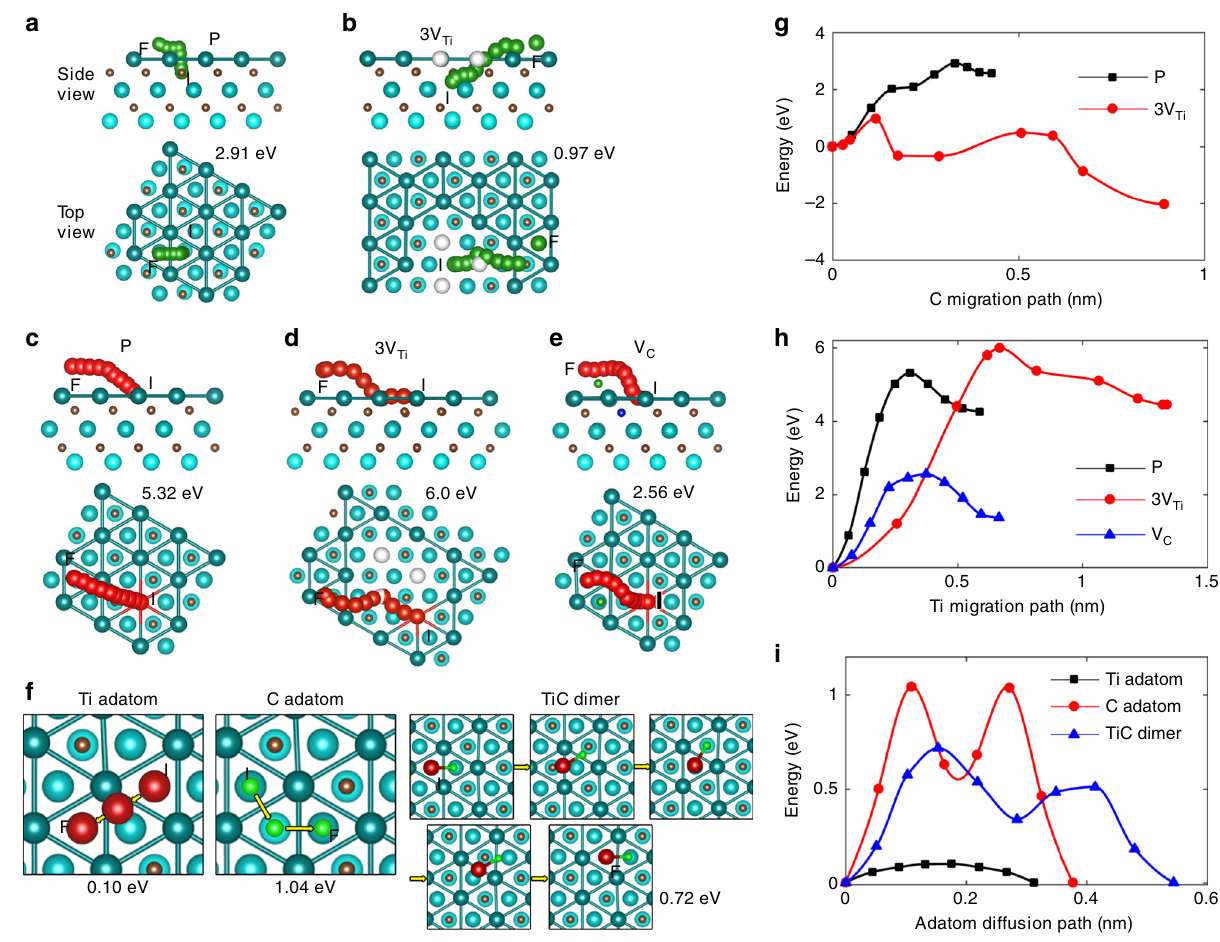
Fig. 3 Migration and diffusion barriers for Ti and C atoms. a – e Carbon atom migration pathways for a perfect crystal ( “ P ” , a ), and with help of 3-V Ti cluster ( “ 3V Ti ” , b ); and titanium atom migration pathways for a perfect crystal ( “ P ” , c ), with help of 3-V Ti cluster ( “ 3V Ti ” , d ), and with help of a single C vacancy ( “ V C ” , e ). “ I ” and “ F ” denote the initial and fi nal positions of the migration paths. Cyan, Ti; gold, C; red, diffusing Ti atom; green, diffusing C atom; white, Ti vacancy site; blue, C vacancy site. f Diffusion pathways of Ti adatom, C adatom, and TiC dimer on the Ti 3 C 2 surface. The migration or diffusion energy barrier for each case in a – f is labeled in eV. g , h Calculated energy along the migration paths for C ( g ) and Ti ( h ) from Ti 3 C 2 body to Ti 3 C 2 surface. i Energy along the diffusion paths on the Ti 3 C 2 surface for a Ti adatom, a C adatom, and a TiC